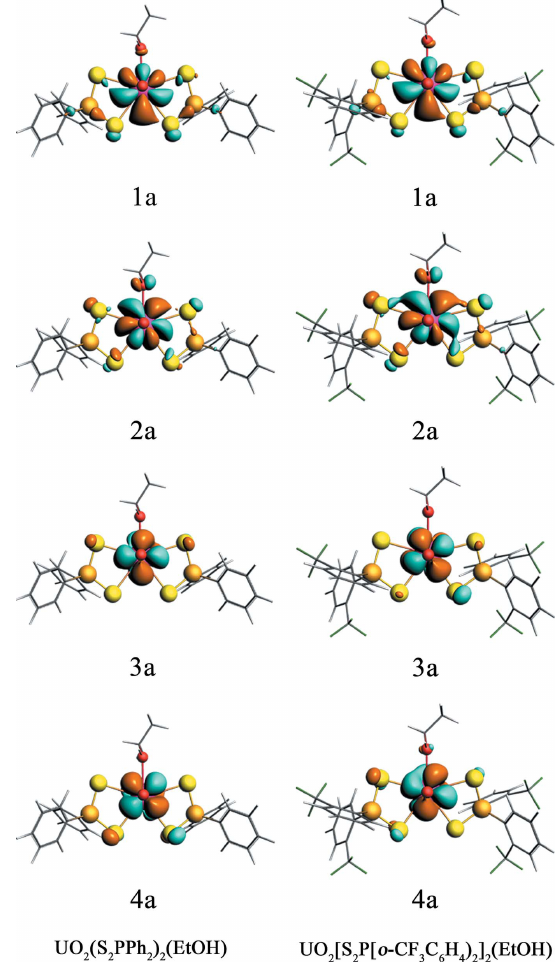
Figure 6 The contours of unoccupied Kohn–Sham orbitals (1–4a) containing primarily U 5 f character for UO 2 (S 2 P R 2 ) 2 (EtOH) in 0.02 a.u.